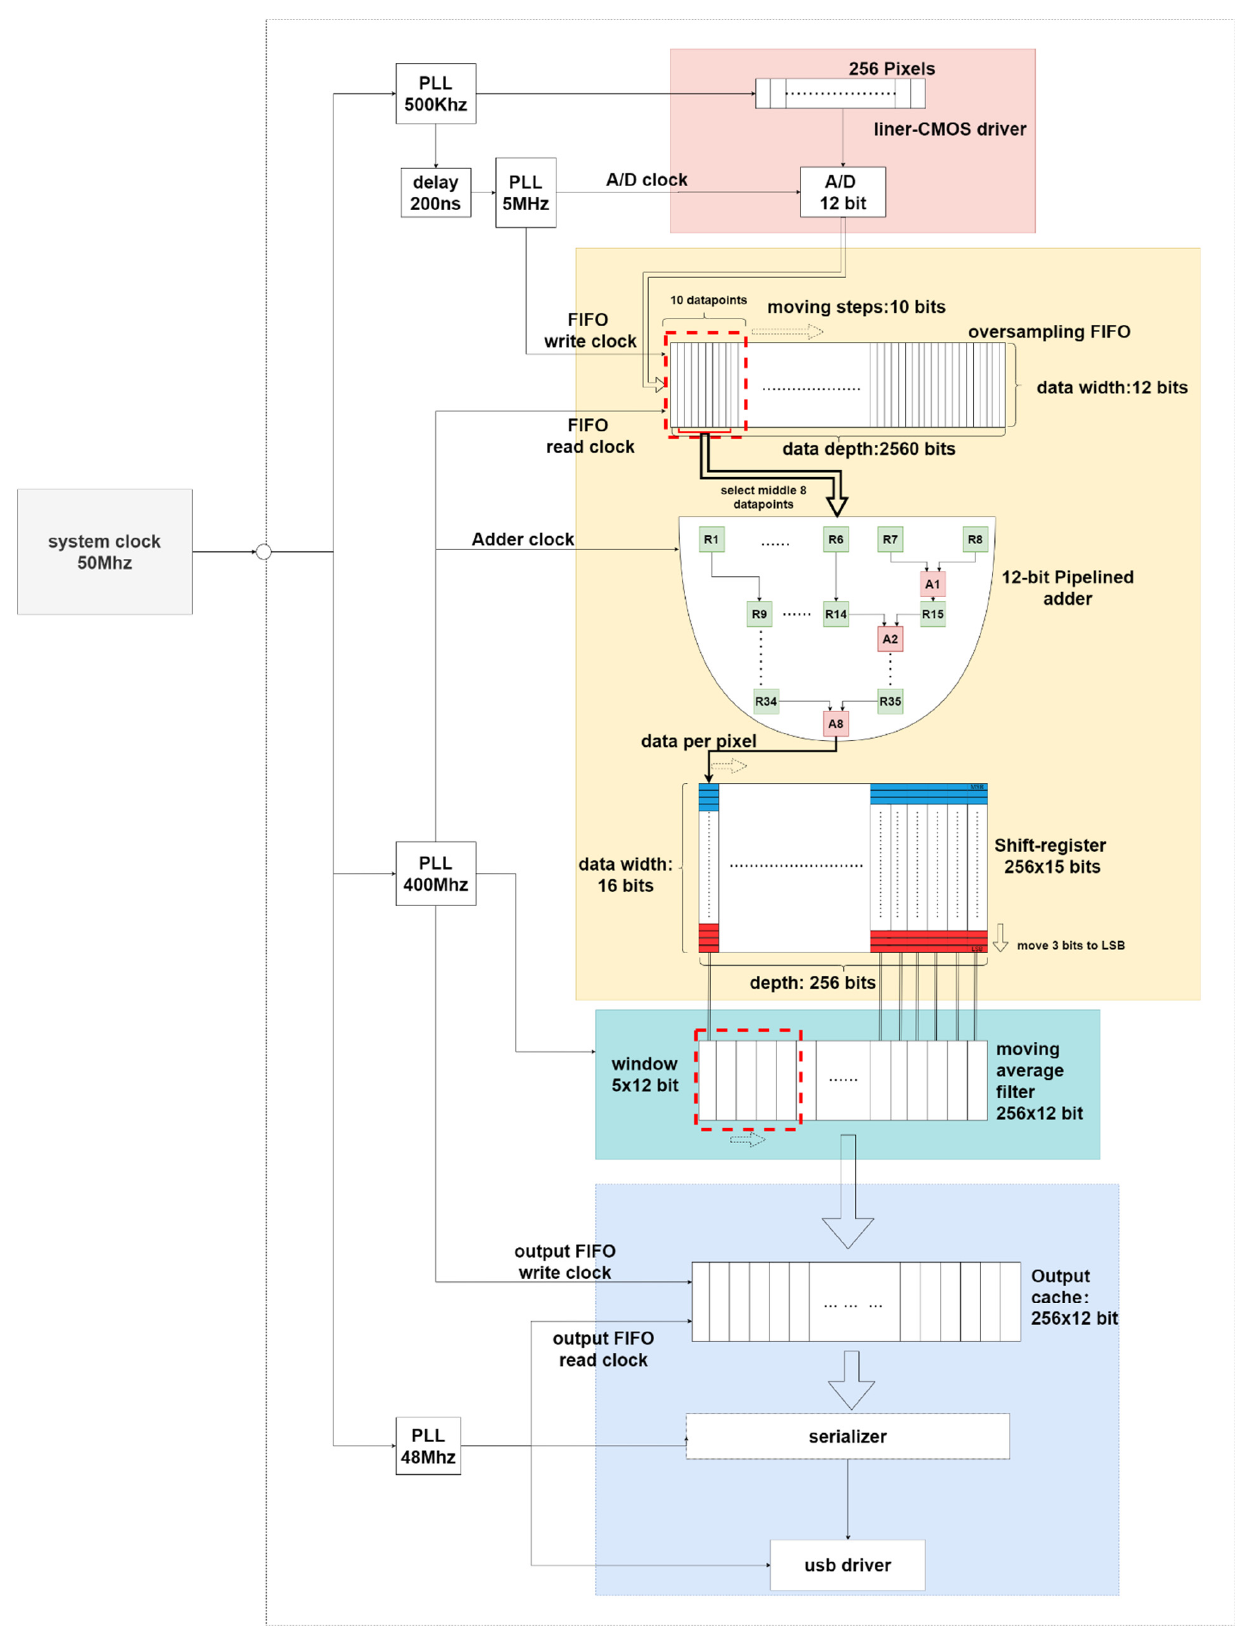
Figure 4. Schematic diagram of the CMOS driver unit, spectral data processing unit and data transmission unit of the spectrophotometer on the FPGA board.